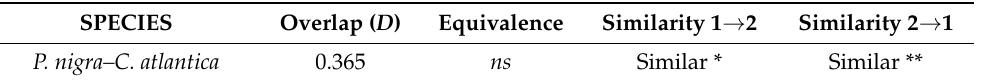
Table 2. Niche overlap of Pinus nigra and Cedrus atlantica and equivalence and similarity tests. Similarity implies two asymmetric analyses (niche → surrounding environment; 1 and 2 represent P. nigra and C. atlantica , respectively). SPECIES Overlap ( D )